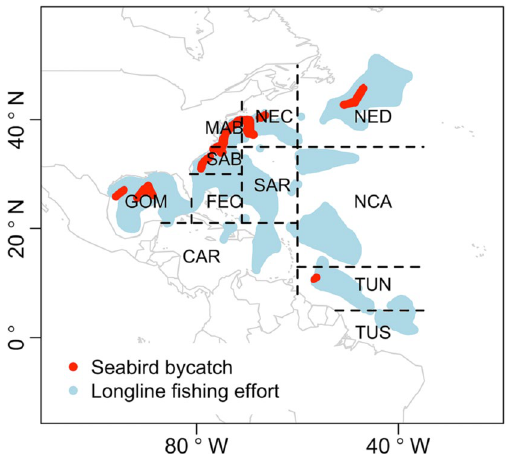
Figure 1. Spatial distribution of observed longline sets (blue area) and those with seabirds caught (red strips) in 11 fishing zones from 1992 to 2017. Abbreviations represent the following: NED – Northeast district, NCA – North Central Atlantic, TUN – Tuna North, TUS – Tuna South, NEC – Northeast coast, SAR – Sargasso region, CAR – Caribbean region, MAB – Mid-Atlantic bight, SAB – South Atlantic bight, FEC – Florida east coast, GOM – Gulf of Mexico. Plot is made using R package ggplot2 (version 3.3.2, https:// ggplo t2. tidyv erse. org) in statistical program R (version 3.6.3, http:// www.R- proje ct. org/). Map data is from R package maps (version 3.3.0, https:// CRAN.R- proje ct. org/ packa ge=